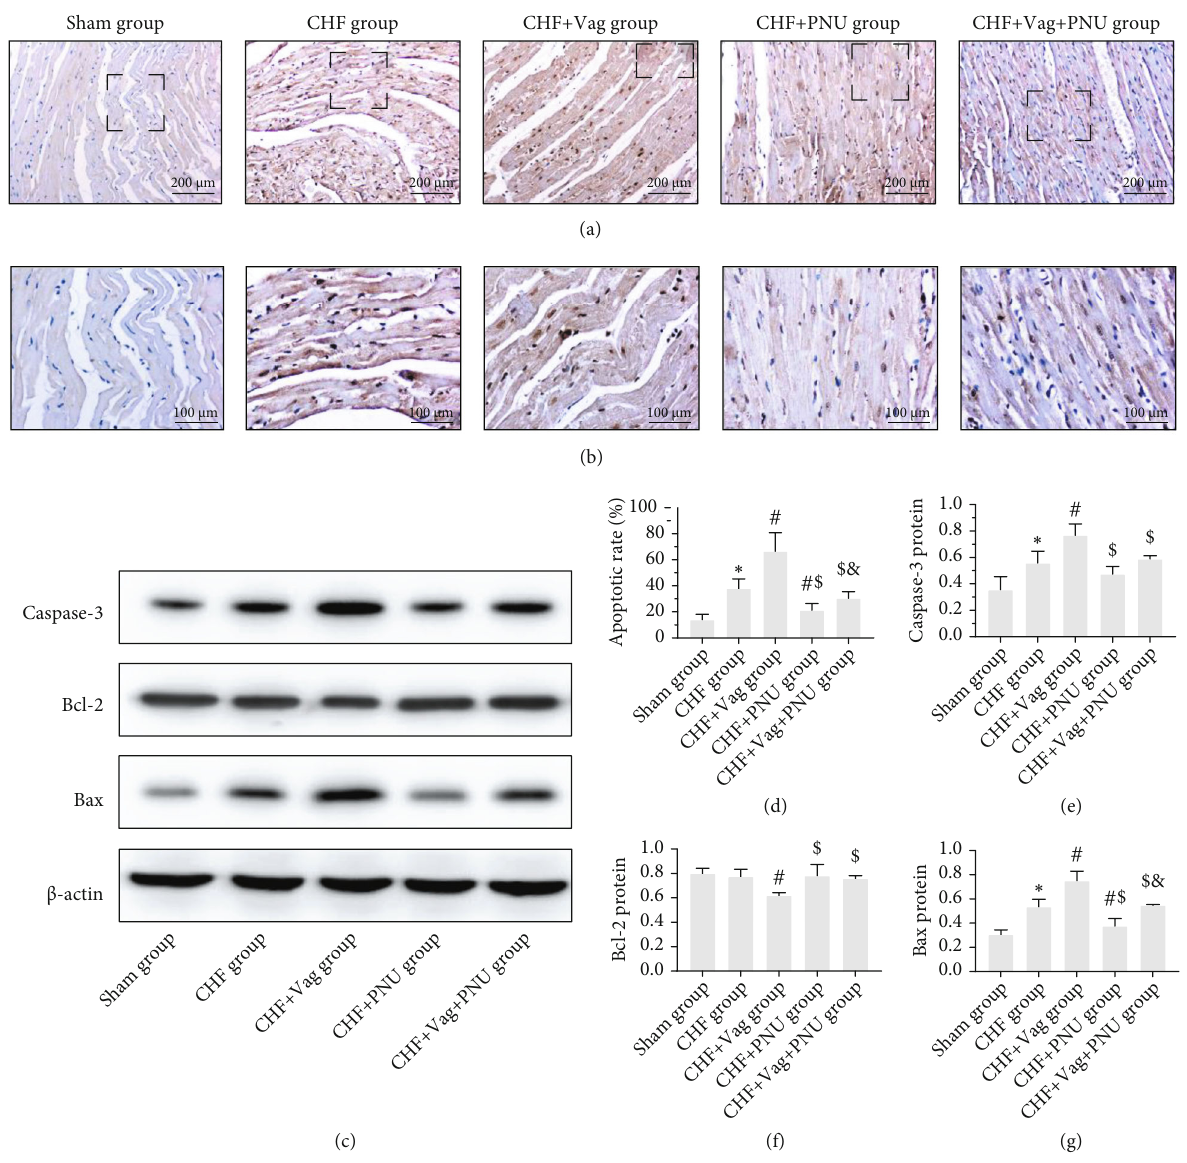
Figure 5: E ff ects of cholinergic elicitation on mitochondrial-dependent apoptosis. Representative images and detailed drawings of TUNEL staining among fi ve groups ((a) × 10; (b) × 20). Western blot results for caspase-3, Bcl-2, and Bax of fi ve groups (c). Quantitative statistical results of apoptotic rate (d) and relative expression levels of apoptosis-related proteins (e – g). ∗ P < 0 : 05 vs. Sham group. # P < 0 : 05 vs. CHF group. $ P < 0 : 05 vs. CHF+Vag group. & P < 0 : 05 vs. CHF+PNU group. Bcl-2: B cell leukemia/lymphoma 2; Bax: Bcl-2-associated